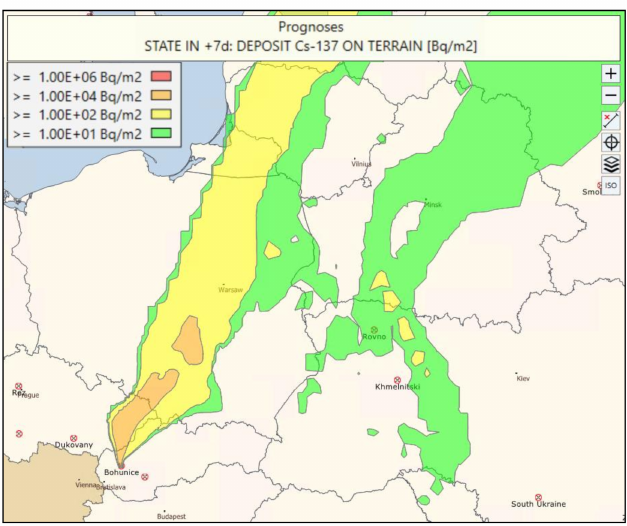
Figure 4. Total ground deposit of Cs-137 in +7 days from the time of release. The deposit is a result of the release of 1 × 10 15 Bq of Cs-137 from Bohunice NPP, at 10:00 UTC on 9 November 2020.